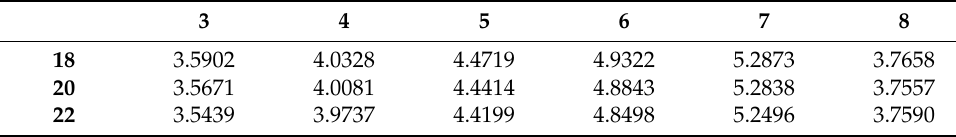
Table 4. The ef f ( j , k ) value of the Daubechies family (wavelet length 18–22).